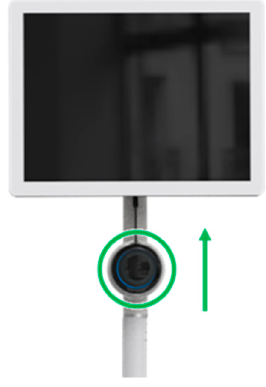
Figure 12. Mouse 3D Height.